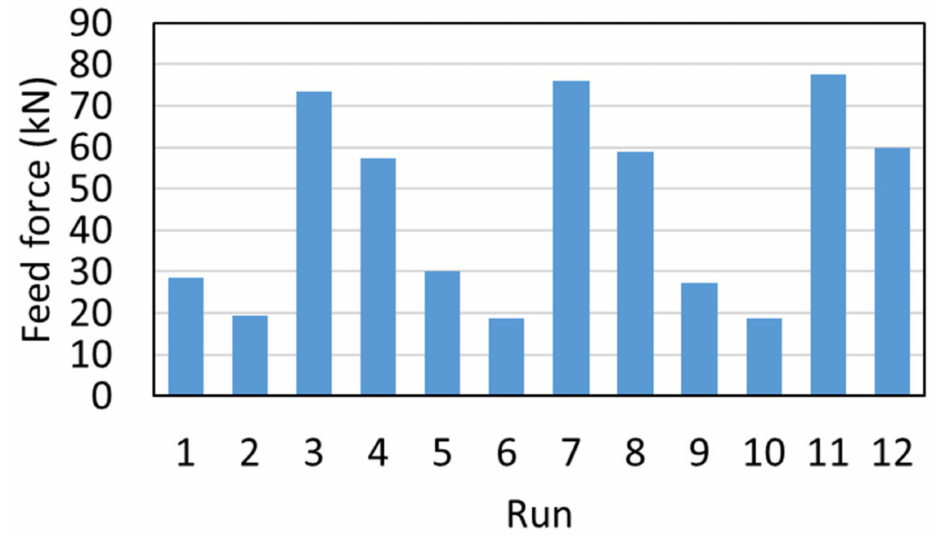
Figure 12. Average feed force in the steady-state region. Table 8. Estimated effects and coefficients for the feed